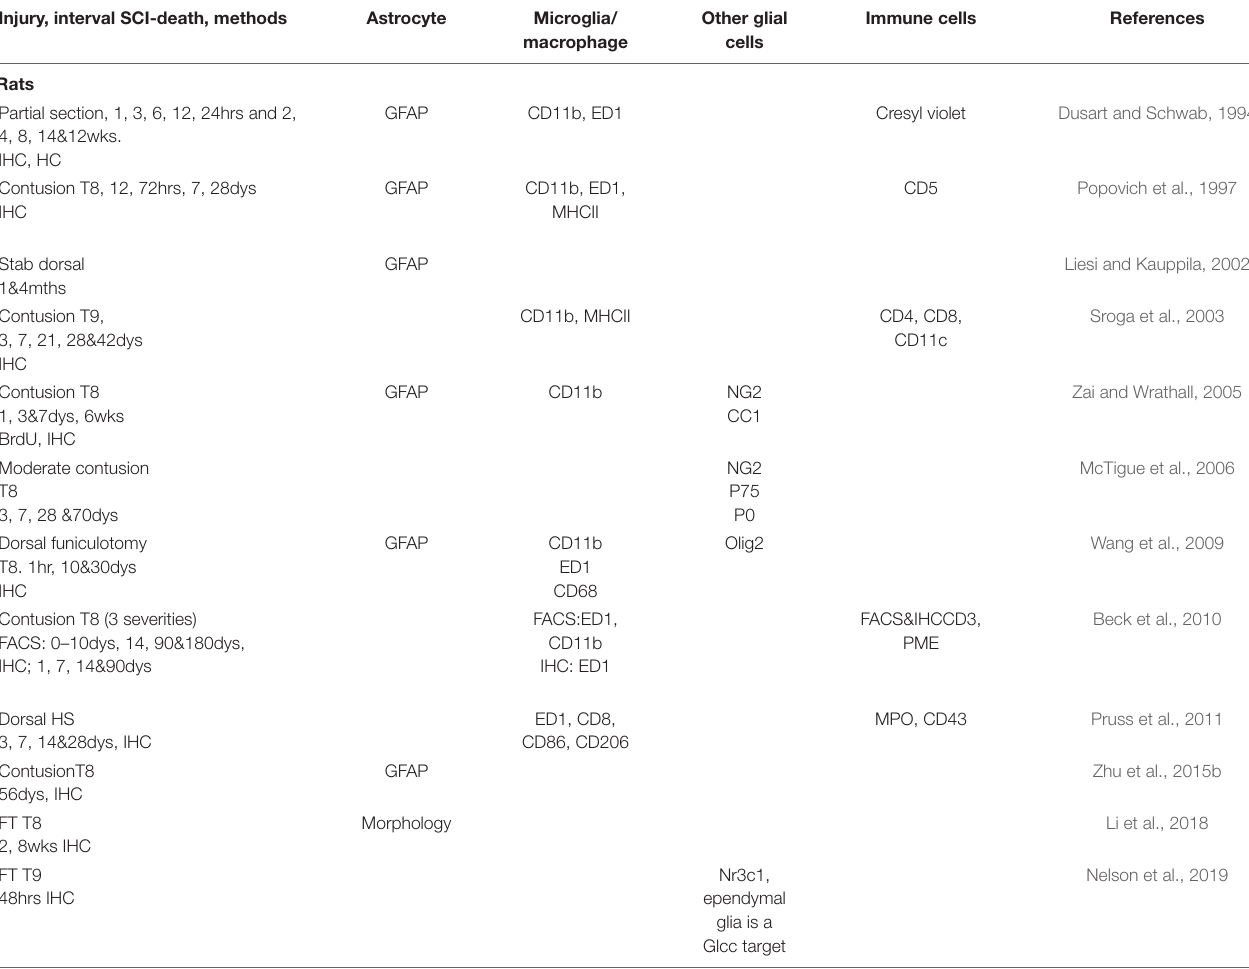
TABLE 2 | Studies demonstrating roles of the glial and immune cells after SCI in